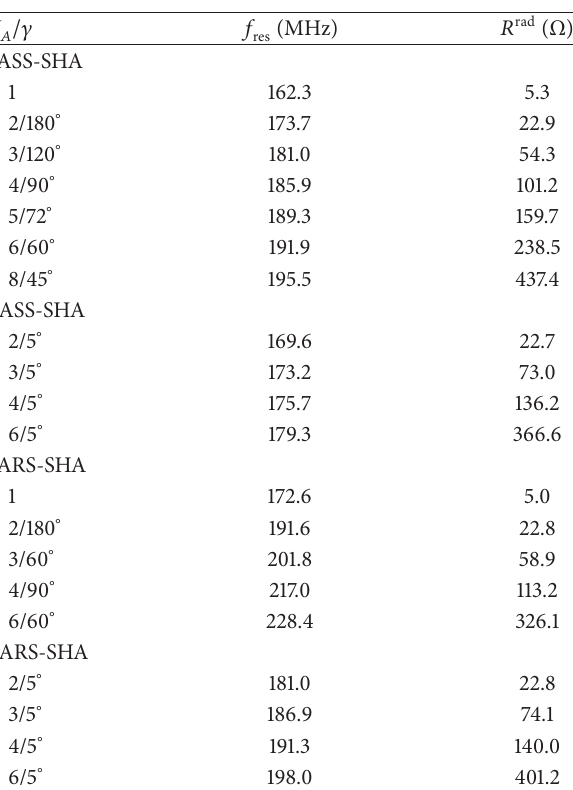
Table 1: PEC SHAs’